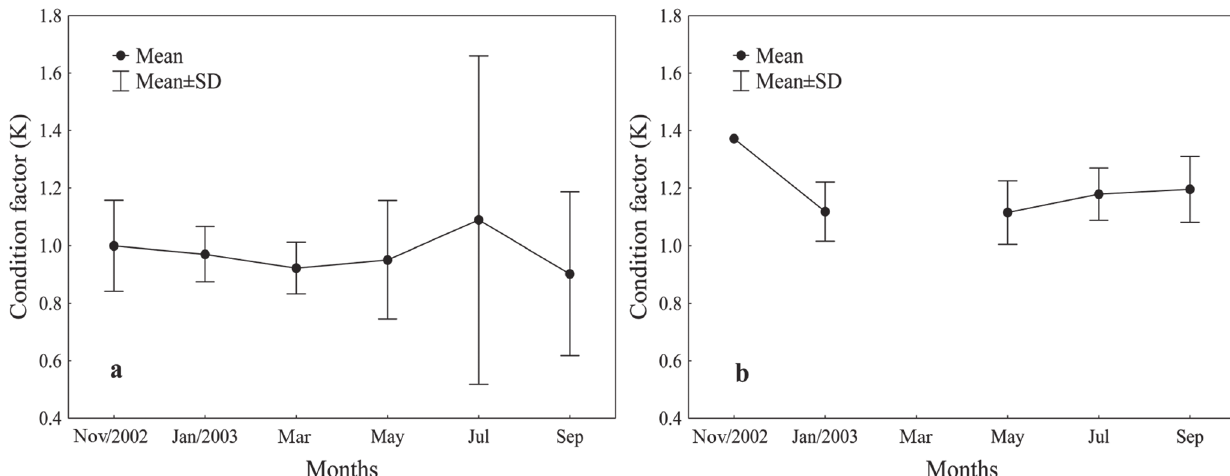
Fig. 5 . Bimonthly variation of the mean values of the condition factor for females (a) and males (b) of Iheringichthys labrosus in the Piquiri River from November 2002 to September 2003. (SD = Standard deviation).